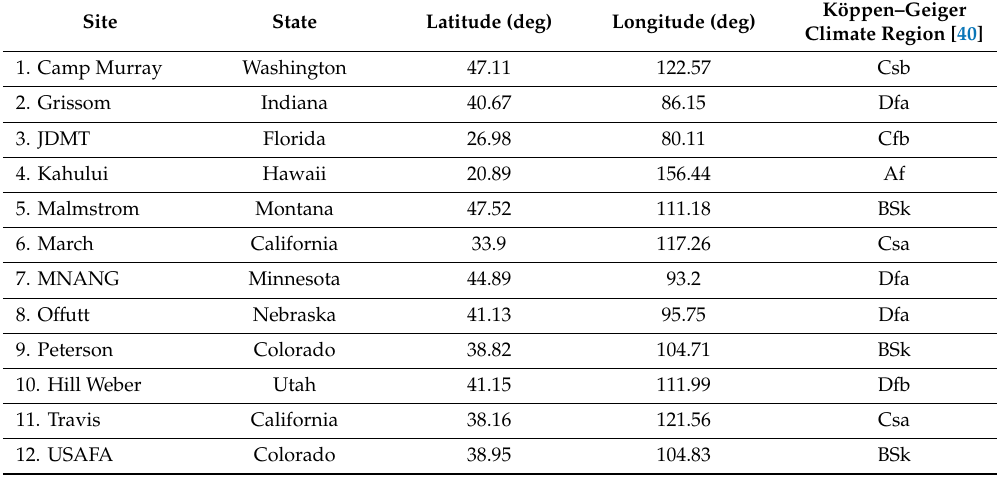
Figure 1. Geographic locations of data collection sites. Table 2. Name and coordinates of data collection sites.